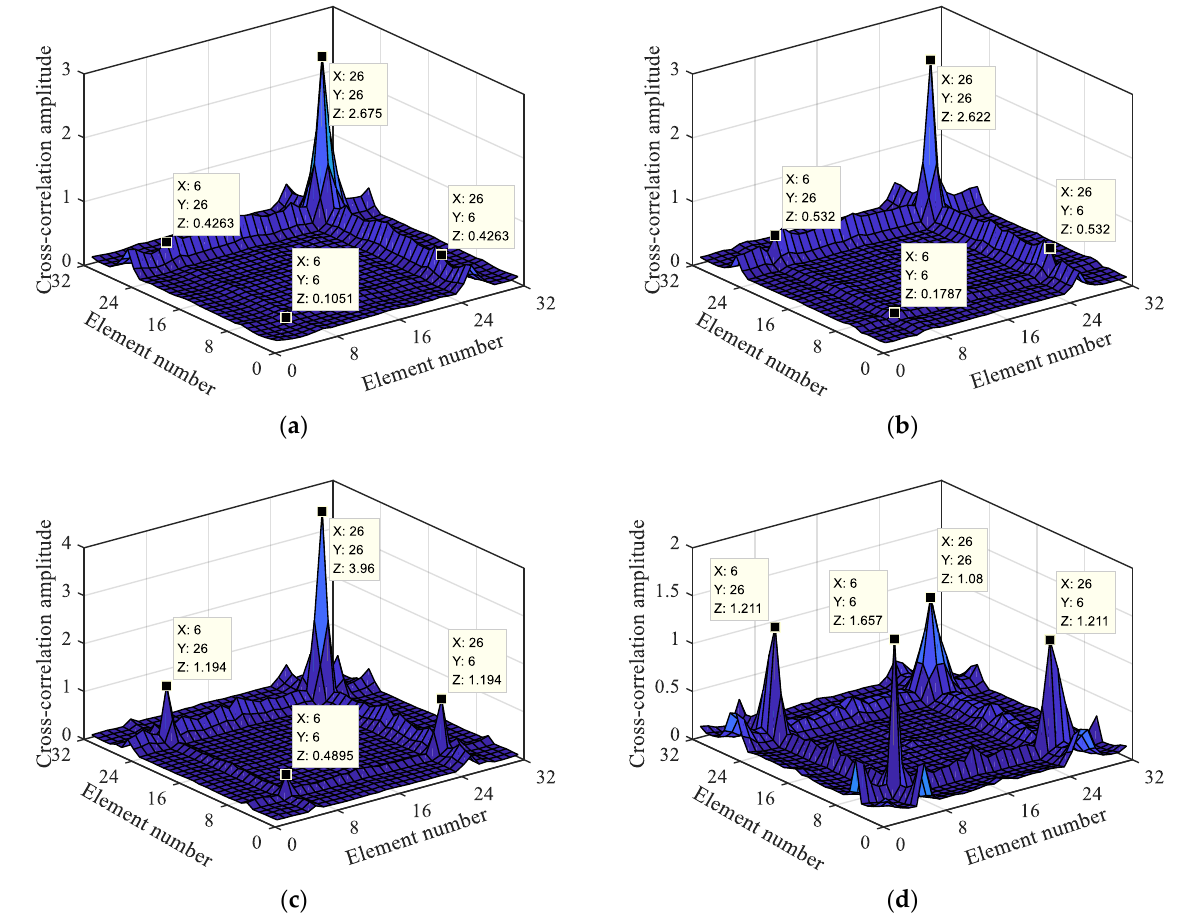
Figure 11. Macro-dynamic strain cross-correlation based on two damage locations with different damage levels; ( a ) Level 1 + Level 4; ( b ) Level 2 + Level 4; ( c ) Level 3 + Level 4; ( d ) Level 4 + Level 4.